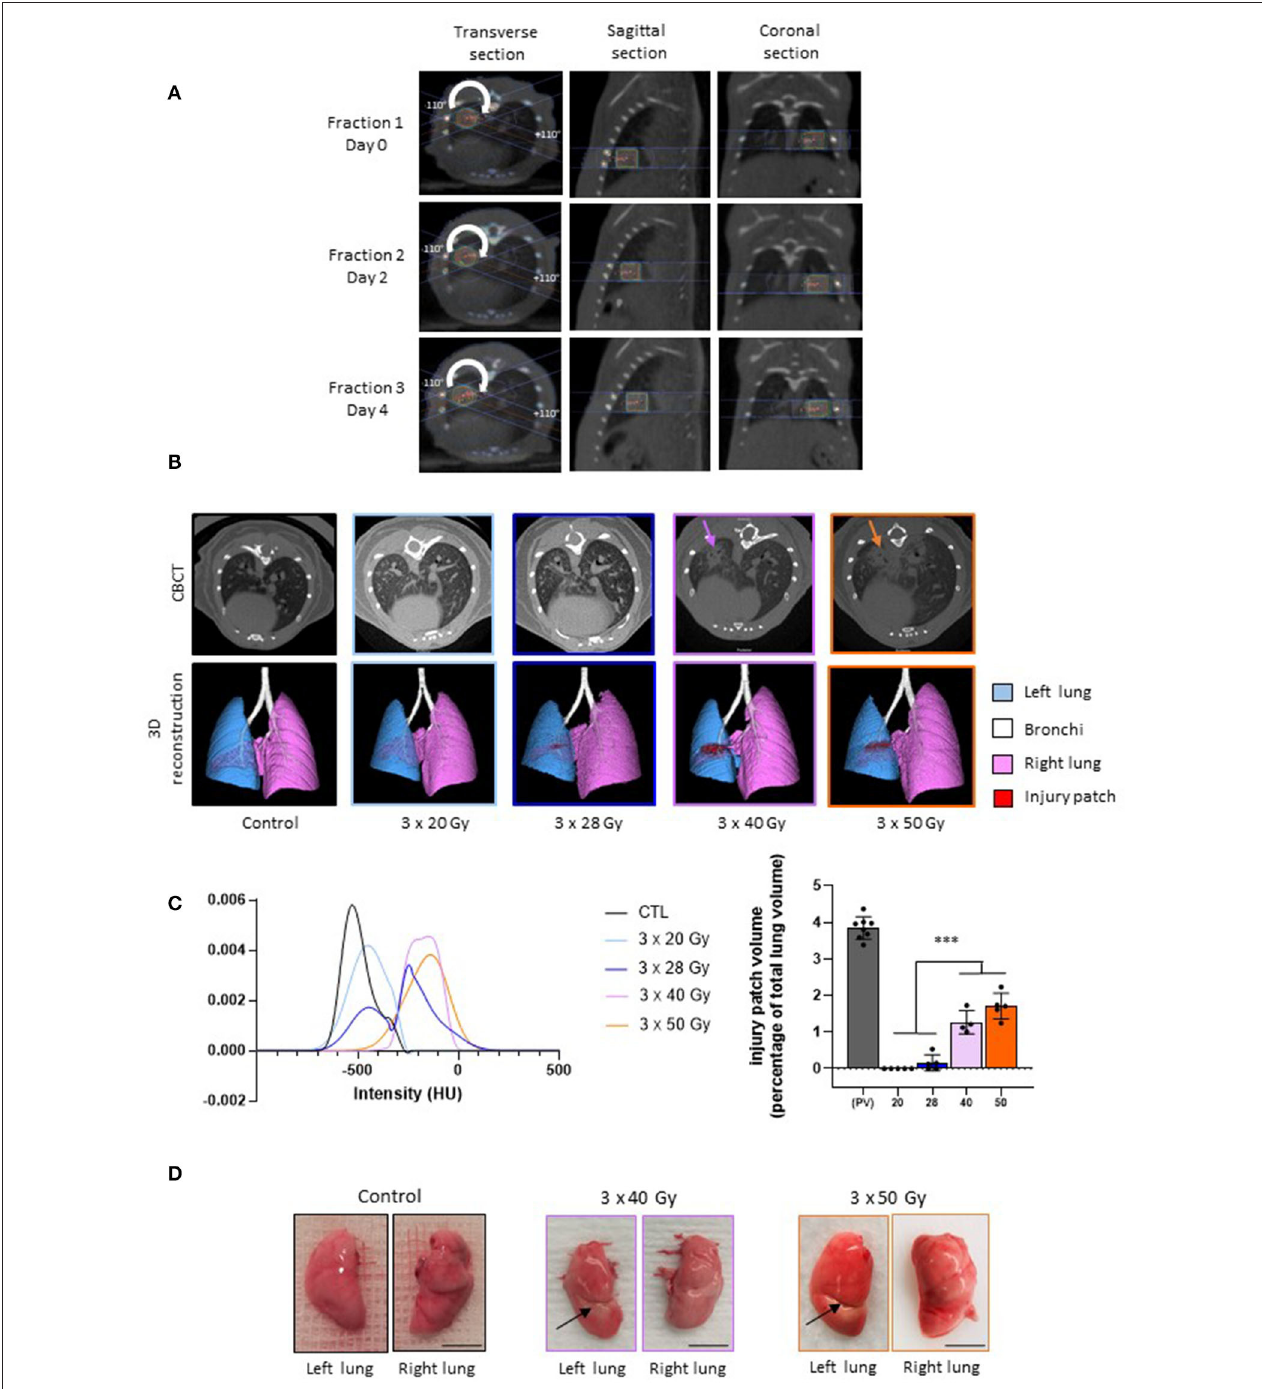
FIGURE 1 | Lung fractionated stereotactic arc therapy generates long-term lung fibrosis. (A) Treatment planning and repositioning for fractionated dose to the left lung in mice. Representative dose distribution of each fraction performed at Days 0, 2, and 4, with Day 0 as the day of the first fraction. Arc-therapy was applied from − 110 ◦ to + 110 ◦ (arrow). Images are given for the 3 × 40Gy schedule. (B) Micro-computed tomography and 3-dimensional reconstructions performed in control mice and 6 months post-exposure to three fractions of 20, 28, 40, and 50Gy irradiation. Arrows indicate focal radiation-induced lung opacification. (C) Left panel: smoothed mean intensity representation, in Hounsfield Units (HUs), in the patch (or in the corresponding area) from groups of mice exposed to 3 × 20, 28, 40 or 50Gy compared to control values; right panel: volume of the injury patch and expressed as a percentage of the total lung volume compared to the calculated planned volume (PV) exposed to ionizing radiation. For irradiated tissues, colors are the same as in the left panel. *** p < 0.001 compared to the target volume (TV) group. (D) Example of macroscopic observation of left and right lungs in control mice and 6 months following 3 × 40 and 3 × 50Gy. Arrows indicate radiation-induced stricture. n = 4–8 per group. Scale bar represents